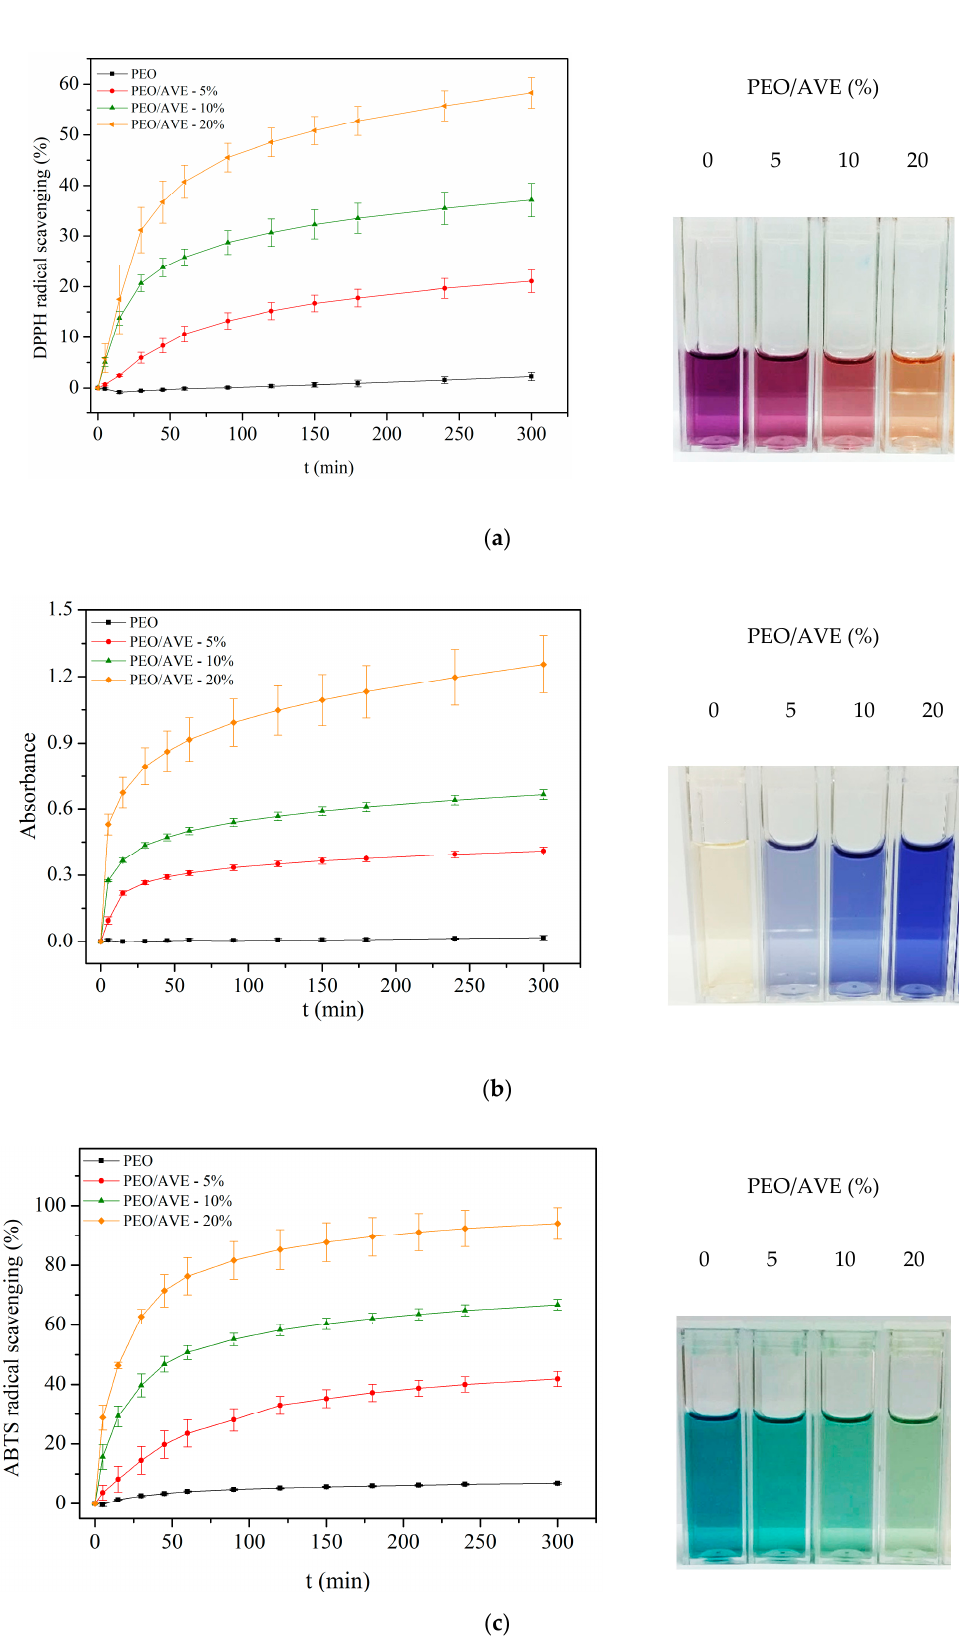
Figure 5. Antioxidant activity of PEO/AVE nanofibers with time by ( a ) DPPH ( b ) FRAP and ( c ) ABTS assays. Final colour solutions are shown at t = 300 min.